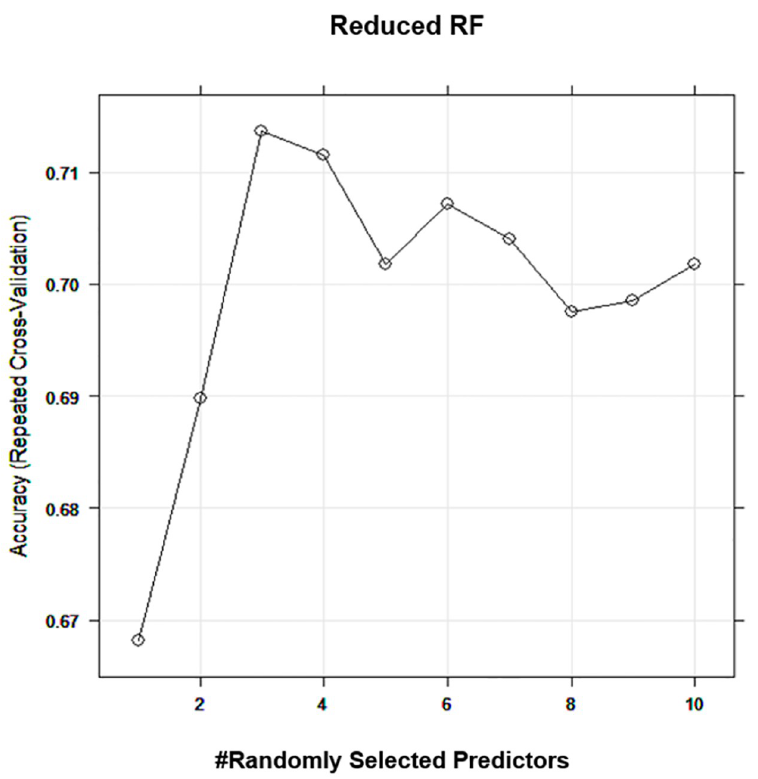
Fig 3. Tuning hyperparameter for reduced RF model. The best mtry for the reduced RF model based on the 10-fold cross-validation.